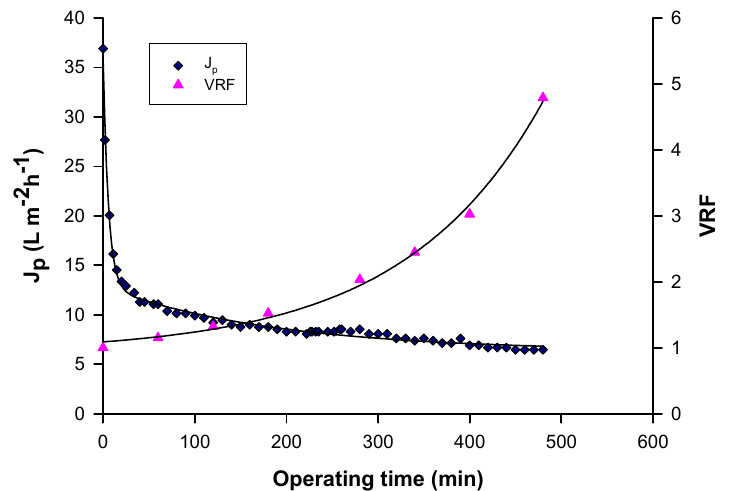
Figure 2. Time evolution of permeate flux and volume reduction factor (VRF) in the clarification of pomegranate juice with hollow fibre UF membranes (Operating conditions: TMP, 0.6 bar; Q f , 400 L/h; T, 25 ± 1 °C) [68].